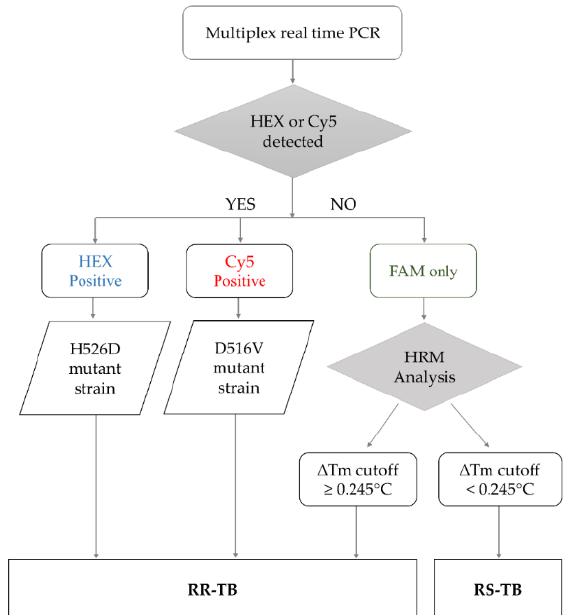
Figure 1. The algorithm for result interpretation of the RIF-RDp assay. H526D and D516V mutations can be detected in the HEX channel and Cy5 channel, respectively, and identified as RR-TB. Other mutations were differentiated based on the ∆ Tm cutoff value. If the ∆ Tm cutoff value is ≥ 0.245 ◦ C, it was interpreted as rifampicin-resistant tuberculosis (RR-TB) and if it is <0.245 ◦ C, it was identified as rifampicin-susceptible tuberculosis